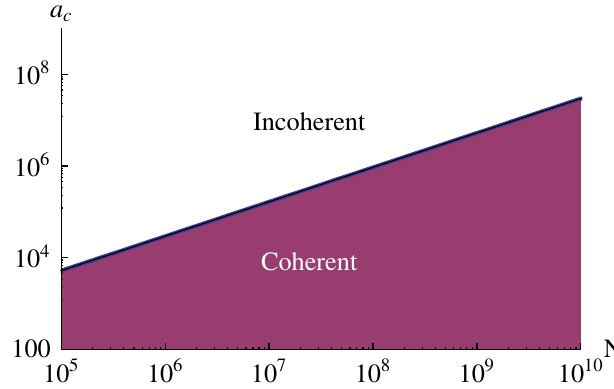
FIG. 19. (Color) The dividing line where the coherent power equals the incoherent power, i.e. the total power is twice the incoherent power. Below this line, the coherent power dominates the total